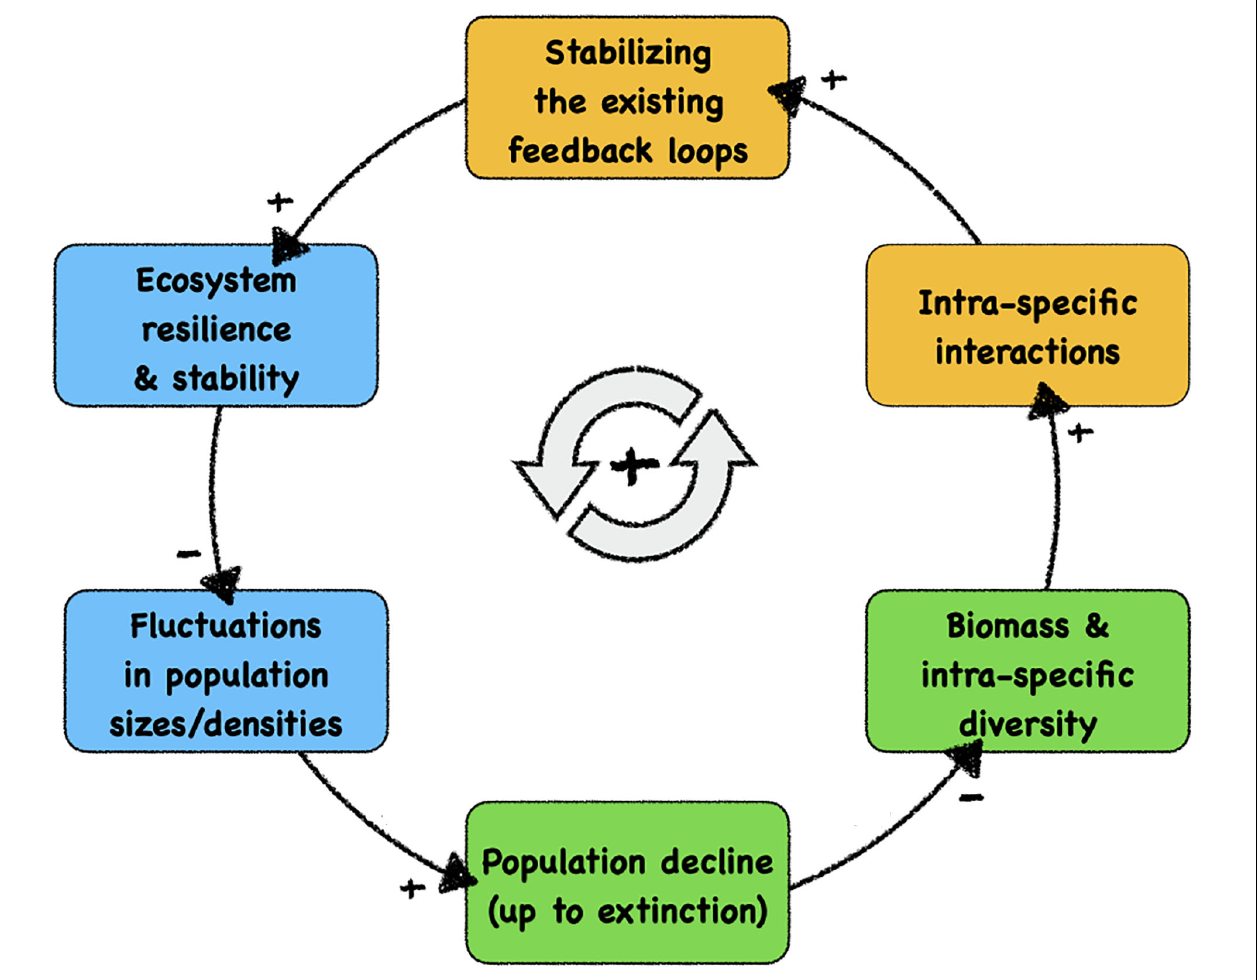
FIGURE 1 | Causal loop diagram of the self-enhancing feedback loop of structural ecosystem decay, which is the likely cause of the current massive decline of biodiversity. We indicate—with background colours—the system components that can be influenced positively by autonomous technological artefacts (robots), ultimately facilitating a technology-based stabilisation of fragile ecosystems. Blue boxes: autonomous robotic probes can measure, observe, and monitor these significant properties and dynamics after being integrated into organism groups. Orange boxes: autonomous robotic agents can modulate these significant processes after being integrated into the relevant organism groups. Green boxes: natural variables in ecosystems that are targetted by our proposed contingency strategy. At the causal link arrows, “+” indicates positively correlated causations between system variables and “–” indicates negative correlated